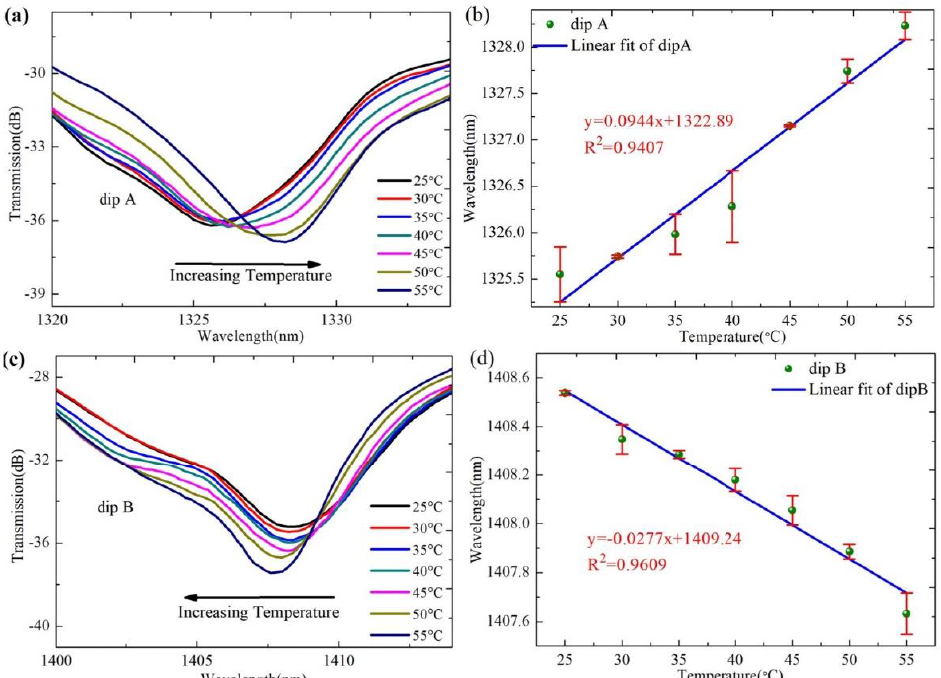
Figure 8. ( a ) The transmission spectra of dip A at different temperature; ( b ) the wavelength shift trends of dip A under different temperature; ( c ) the transmission spectra of dip B at different temperature; and ( d ) the wavelength shift trends of dip B under different temperature.